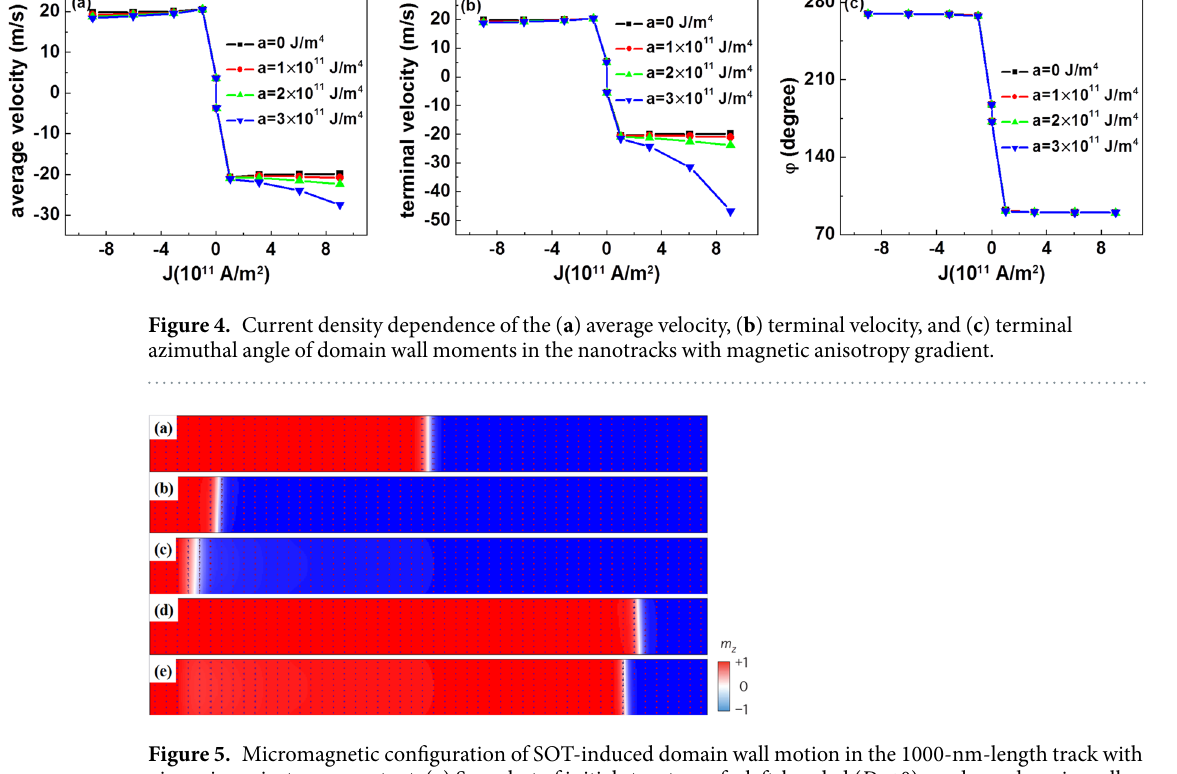
Figure 5. Micromagnetic configuration of SOT-induced domain wall motion in the 1000-nm-length track with piecewise anisotropy constant. ( a ) Snapshot of initial structure of a left-handed ( D < 0) up-down domain wall. Snapshot of the domain wall moving after 20 ns under a current of J = 5 × 10 11 A/m 2 in a track with ( b ) constant anisotropy ( a = 0 J/m 4 ) and ( c ) sloped anisotropy ( a = 3 J/m 4 ). Snapshot of the domain wall moving after 20 ns under a current of J = − 5 × 10 11 A/m 2 in a track with ( d ) constant anisotropy ( a = 0 J/m 4 ) and ( e ) sloped anisotropy ( a = 3 J/m 4